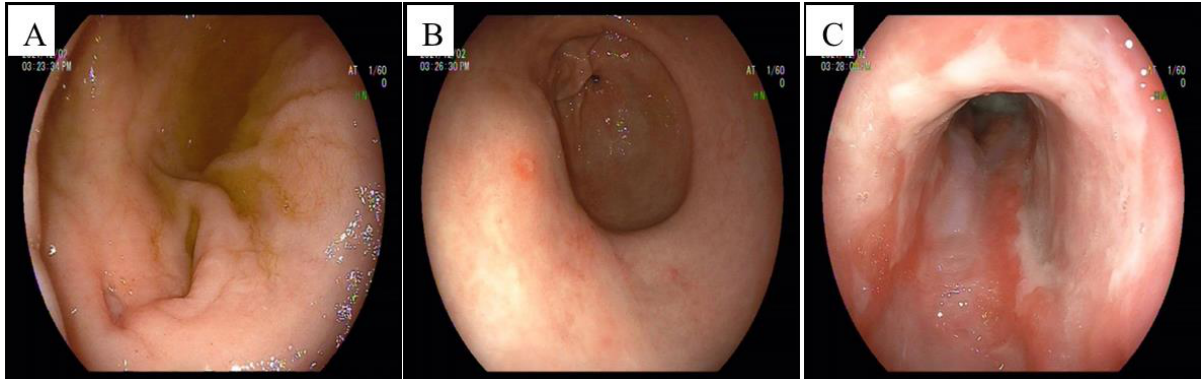
Figure 2. Initial findings of gastroscopy (equipment type: Pentax EG-2990i, Japan, Tokyo). ( A ) An ulcer (0.5 cm) in the anterior wall of the duodenal bulb, and the bulbar cavity showed oedema and stenosis. ( B ) Atrophic gastritis and gastric mucosal erosions. ( C ) The lower part of the oesophagus showed a huge oesophageal ulcer, between 37 cm and 45 cm from the incisors. The ulcer involved the oesophagus for about 4/5 weeks, and was covered with extensive white film.